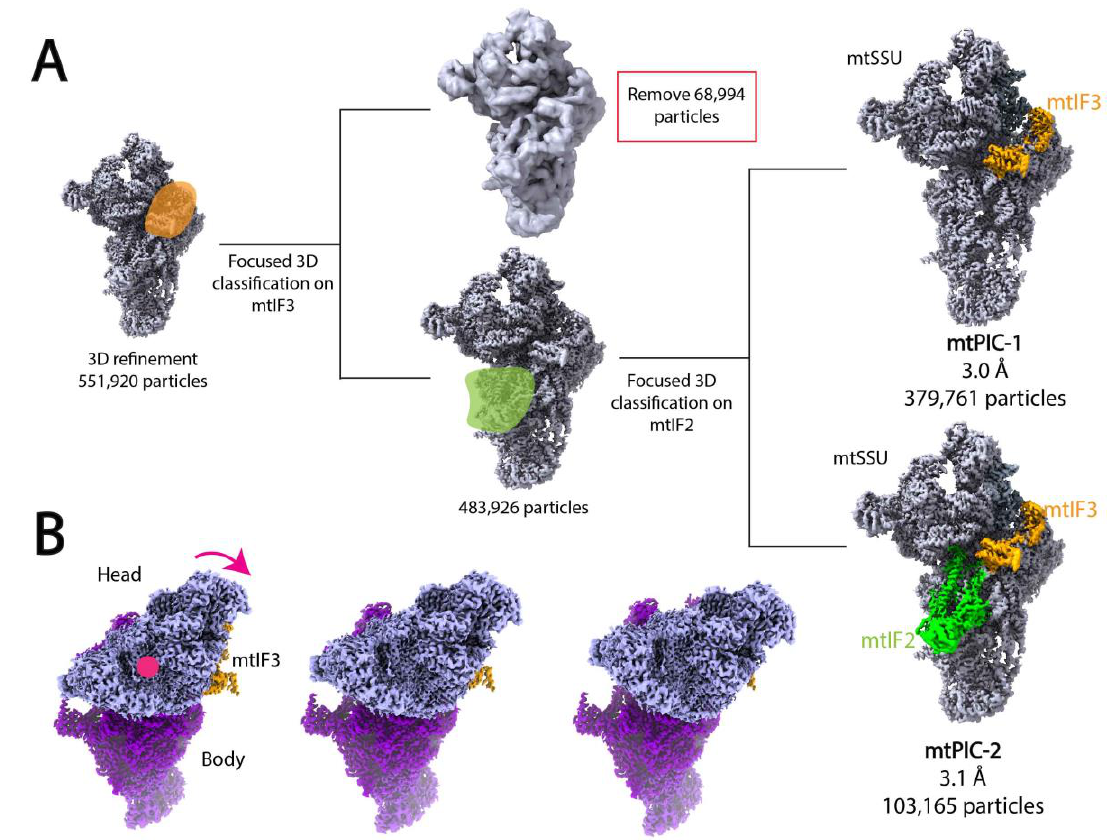
Figure 5. Focused classification elucidates two high-resolution intermediates of human mitochon- drial translation and multi-body refinement reveals mtSSU head-swiveling motion during complex assembly [139]. ( A ) Workflow of focused classification. After 3D refinement, Khwaja et al. performed two rounds of focused refinement and signal subtraction masking the mtIF3 and mtIF2 regions to separate mtIF3 only (mtPIC-1) and mtIF3-mtIF2 bound (mtPIC-2) complexes. mtSSU is shown in gray, mtIF3 and its mask in orange, and mtIF2 and its mask in green. Maps of mtPIC-1 and mtPIC-2 can be accessed with accession numbers EMD-10021 and EMD-10022, respectively. ( B ) Multi-body refinement and subsequent PCA of mtPIC-1 revealed a head swiveling motion emanating from the rotation of rRNA h28. Depicted maps only serve to represent motion and were not experimentally determined. The mtSSU head is shown in light purple, body in purple, and mtIF3 in orange. The pink arrow indicates the direction of motion and pink dot represents the axis of rotation.